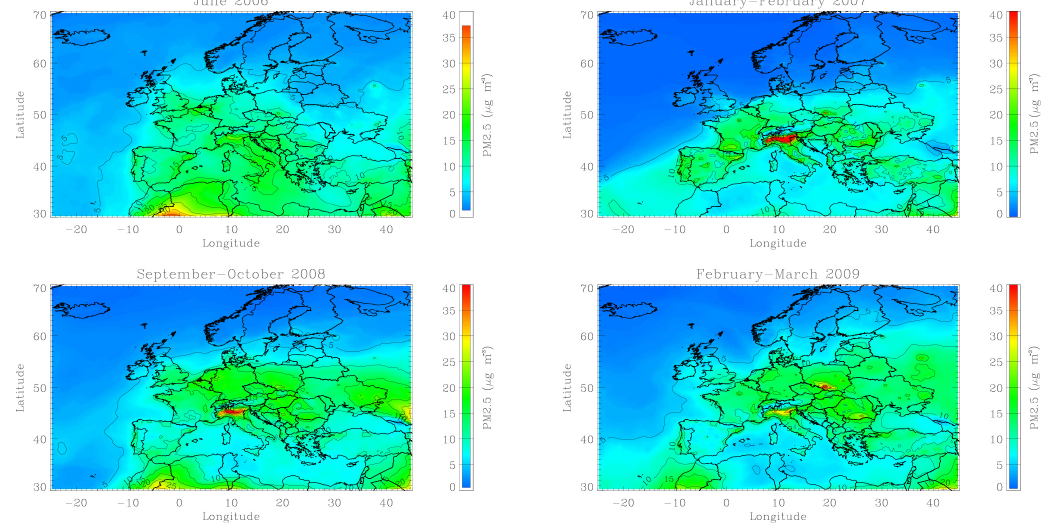
Figure 1. Modelled average PM 2 . 5 concentrations for June 2006, January–February 2007, September–October 2008 and February– March 2009 (top to bottom and left to right) based on the base case (VBS_BC). Note that the colour scale was limited to a maximum of 40µgm − 3 to facilitate comparison of the panels. Table 4. Statistical analysis of OA for NOVBS, VBS_ROB and VBS_BC scenarios for the 11 AMS sites for February–March